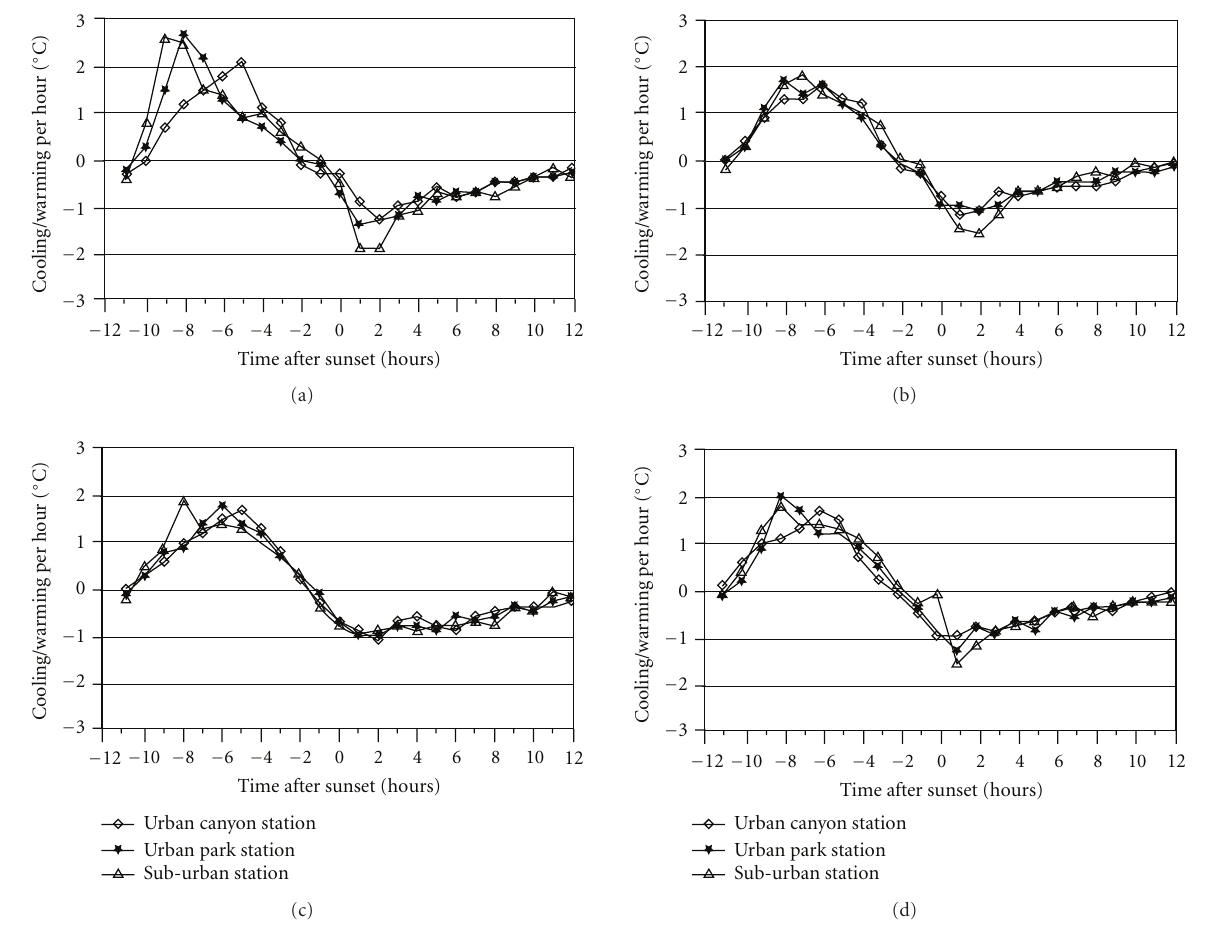
Figure 2: Hourly cooling and warming rates at three sites in Nairobi during di ff erent periods of the year.